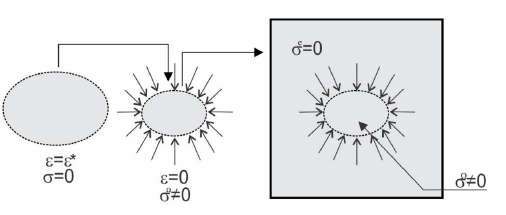
Figure 4: Eshelby's problem strategy.